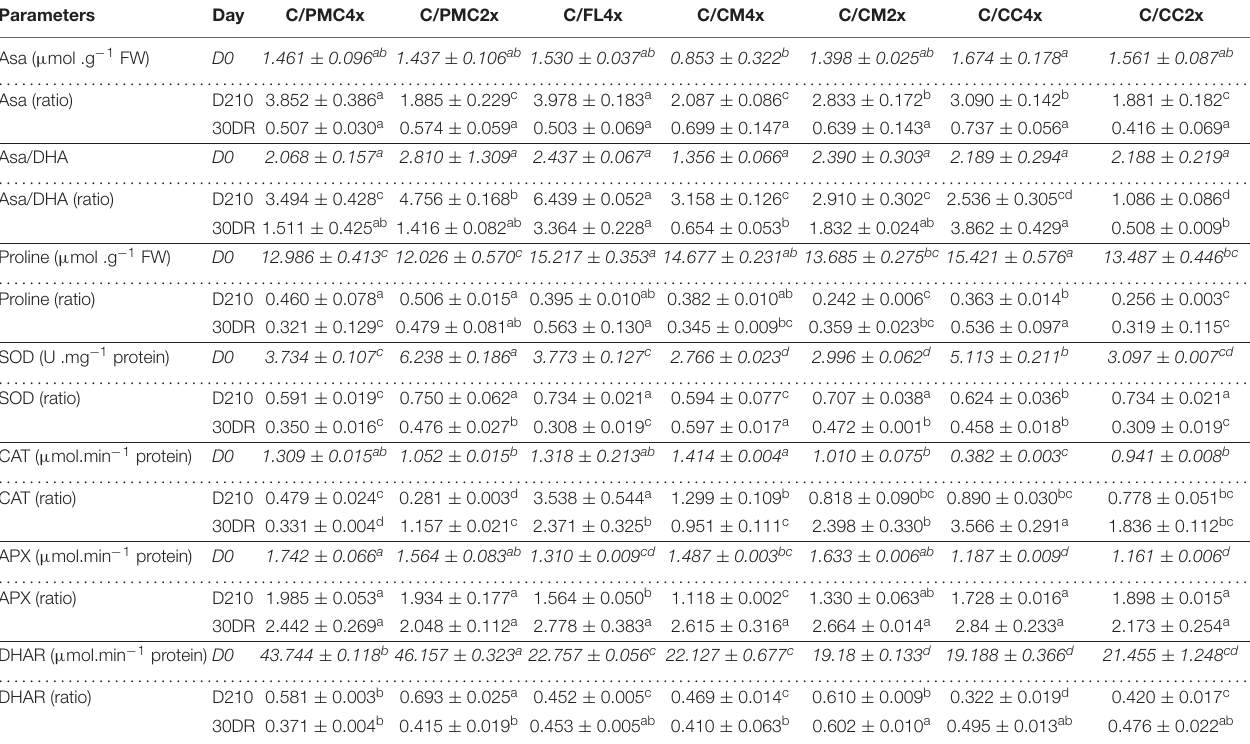
Data shown at D210 and 30DR are means (n = 3 ± standard error) expressed as ratios with respect to the values obtained on control which have not been subjected to stress. For further informations, means values of control data (D0) (n = 3 ± standard error) were also included and indicated by italics characters. Data were analysed using ANOVA and Fisher LSD tests (P < 0.05). Different letters indicate significant differences between genotypes along the time course. D0, control, D210, 210 days after the start of nutritional deprivation, and 30DR, after 30 days of recovery.